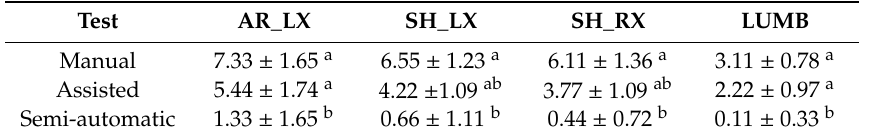
Table 1. Mean frequency of the signal values (MNF) obtained through the electromyographic system.